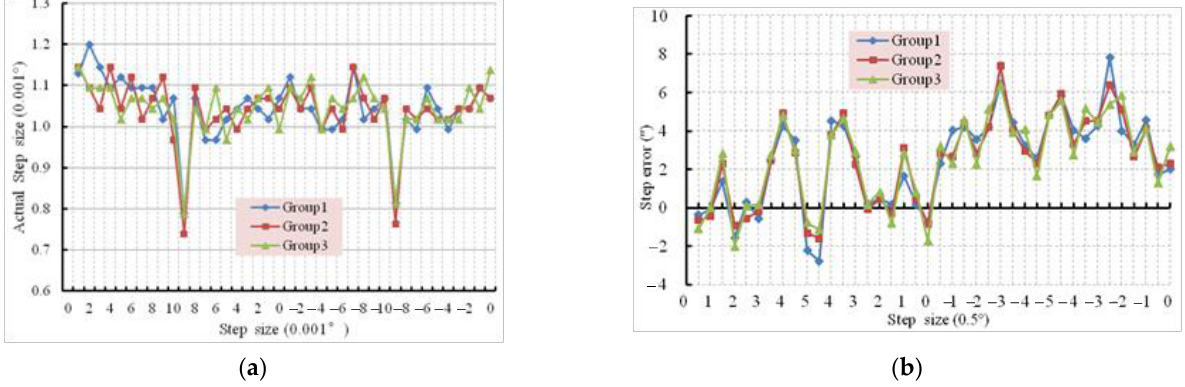
Figure 24. Test results for mobile platform rotation along the X -axis: ( a ) Step size: 0.001°; ( b ) Step size: 0.5°. Table 3. Performance characteristics of the parallel platform.